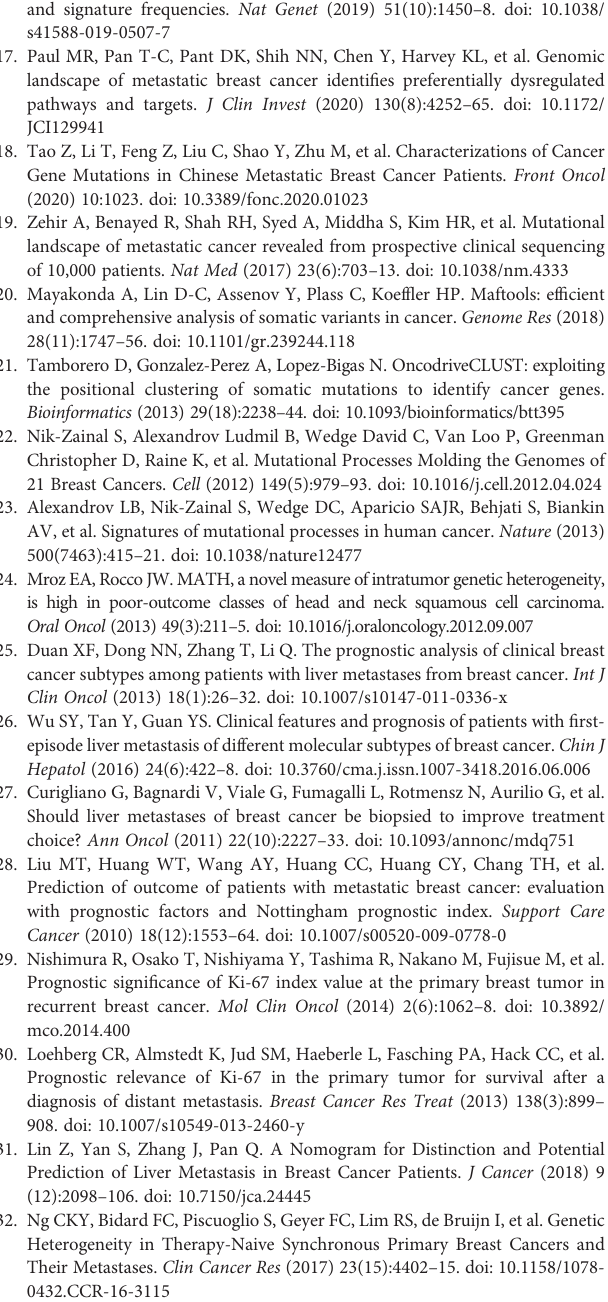
Supplementary Figure 1 | Comparison of the mutation frequency of the four driver genes ( A . ESR1 B . FGFR4 C . ERBB2 D . AKT1) between the MSKCC dataset and the POTUAM dataset. (chi-square test). Supplementary Figure 2 | NomogramsofprognosisforpatientswithLM(excluding CA153_trend). (A) The nomogram of prognosis for patients withPFS (C-index = 0.693). (B) The nomogram of prognosis for patients with OS (C-index = 0.673). Supplementary Figure 3 | Comparison of SMGs between liver metastases and other metastases in the POTUAM dataset. (SMG, signi fi cantly mutanted gene. *p < 0.05, **p < 0.01, ***p <